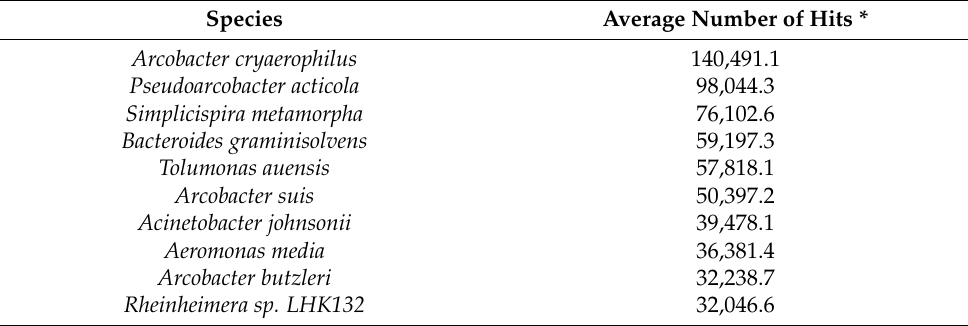
Table 1. List of top metagenomic